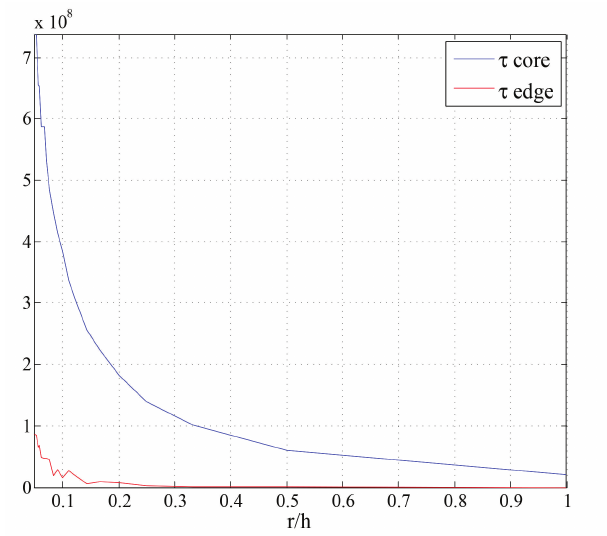
Figure 15. Stress (Pa) at the edge and at the core of the notch, as a function of ρ = r